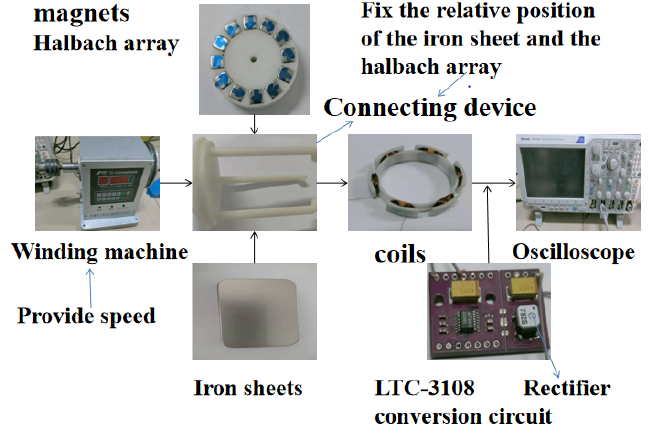
Figure 12. Devices used in the experiment.